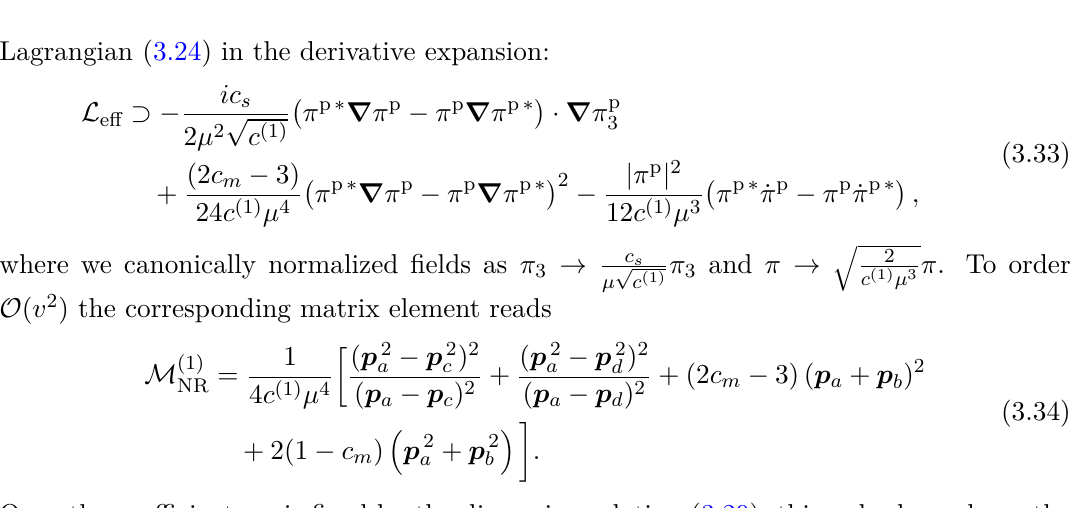
Figure 1 . Diagrams contributing to ππ → ππ at